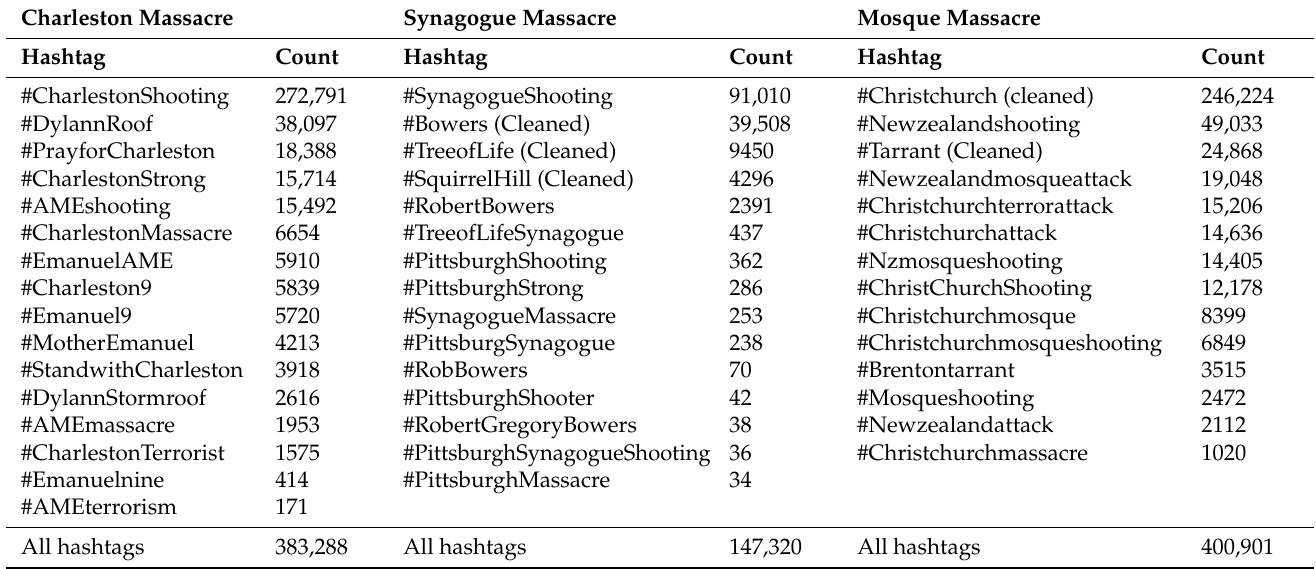
Table 1. Hashtags used for data